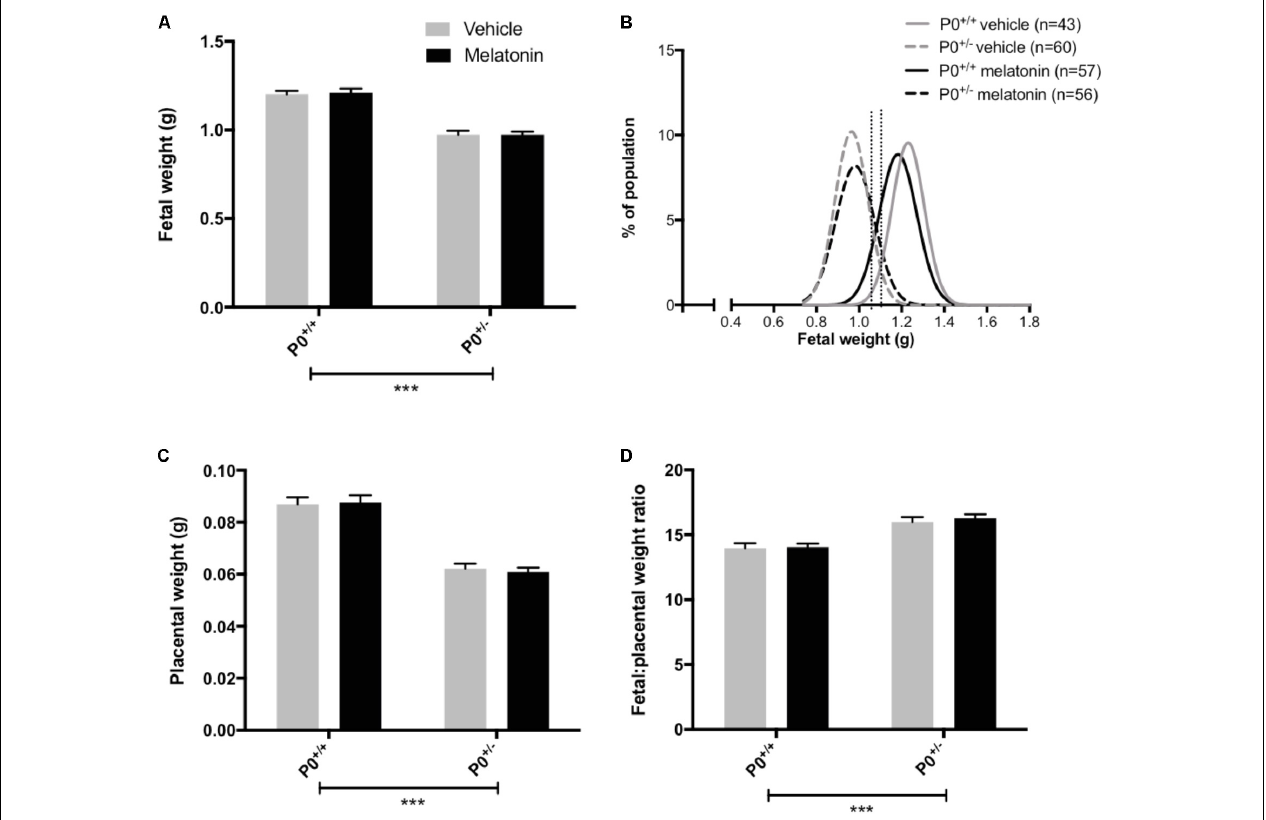
FIGURE 2 | Fetal and placental weights in P0 + / + and P0 + / - mice at embryonic day 18.5. In (A,C,D) , mean + SEM is shown. (B) is a % frequency distribution plot of individual fetal weights with vertical dotted lines denoting the 5th centile (1.02 g, left hand line) and 10th centile (1.06 g, right hand line) of P0 + / + vehicle weights and n = number of fetuses. Number of litters are as follows; P0 + / + vehicle N = 13, P0 + / + melatonin N = 14, P0 + / - vehicle N = 13, P0 + / - melatonin N = 14. ∗∗∗ P < 0.001 Generalized linear mixed models analysis with sequential Sidak post-test.